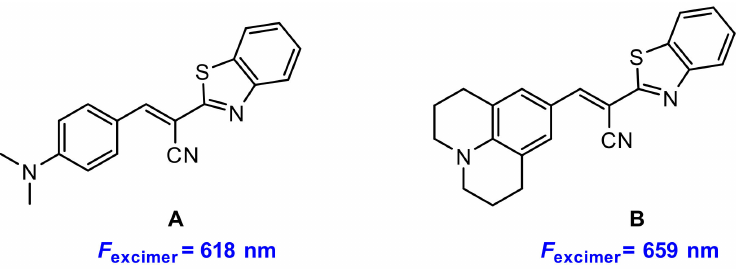
Figure 31. Chemical structures of benzothiazole derivatives 2 and 3 .